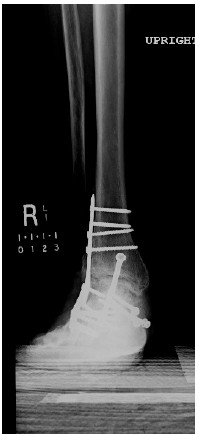
Figure A4. 3 years post-op showing new fracture of the most proximal 3.5 mm locking screw in the talus. Metals 2018 , 8 , x FOR PEER REVIEW